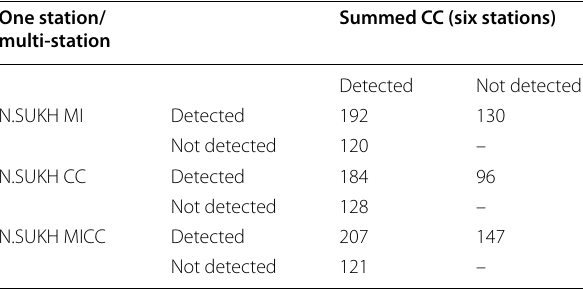
Table 2 Relationships between the summed CC (horizontal axis; six stations) and the three indices (vertical axis) from a single station